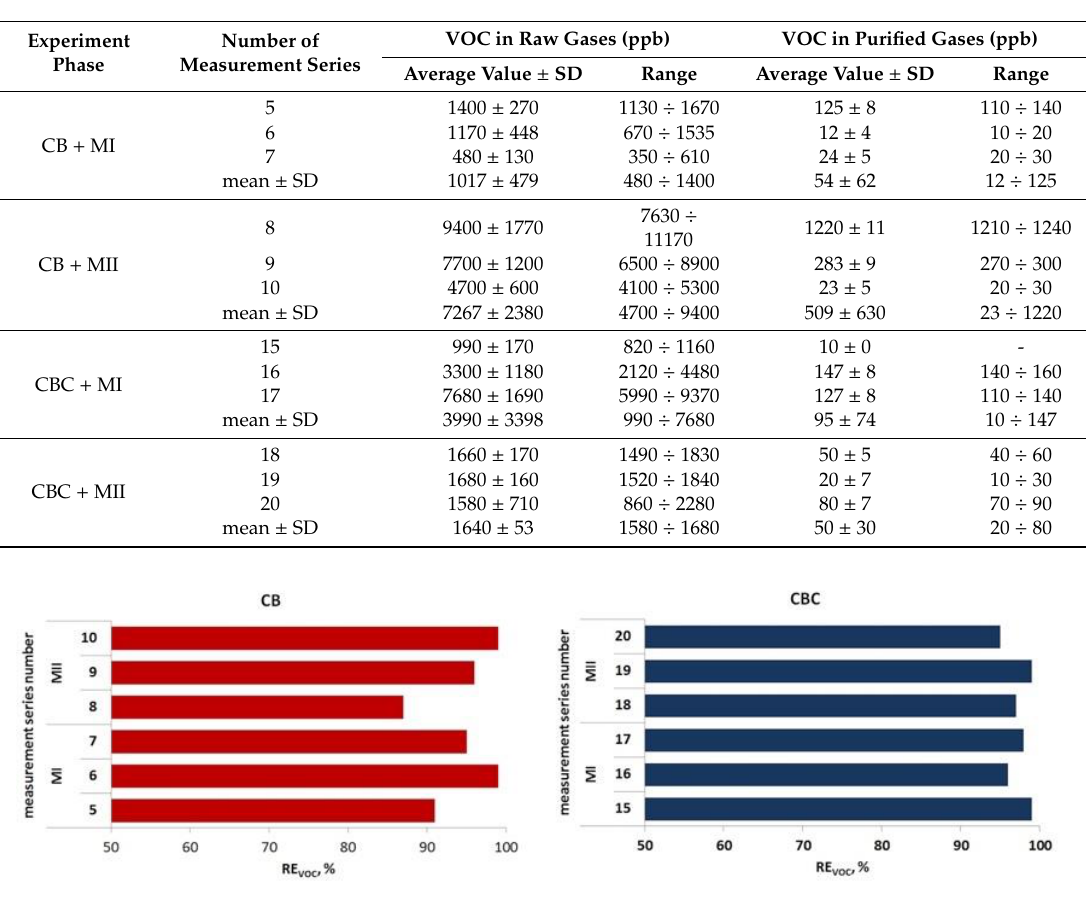
Figure 7. Mean e ff ectiveness of VOC removal in subsequent measurement series of two-stage Figure 7. Mean effectiveness of VOC removal in subsequent measurement series of two-stage biofiltration.